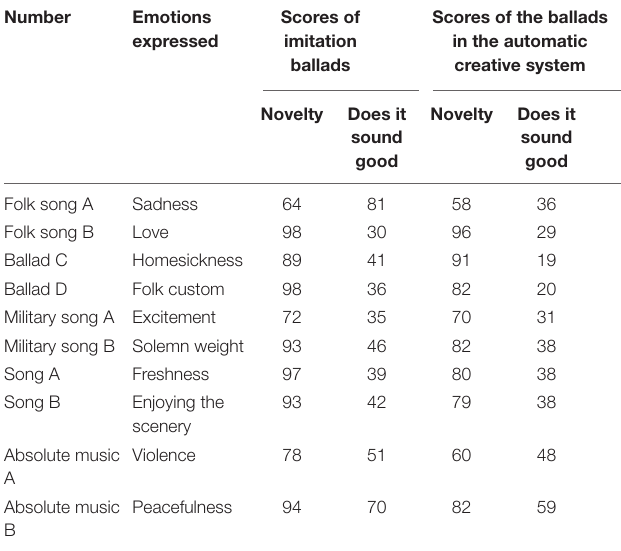
TABLE 2 | Comparison between creative ballads and imitation